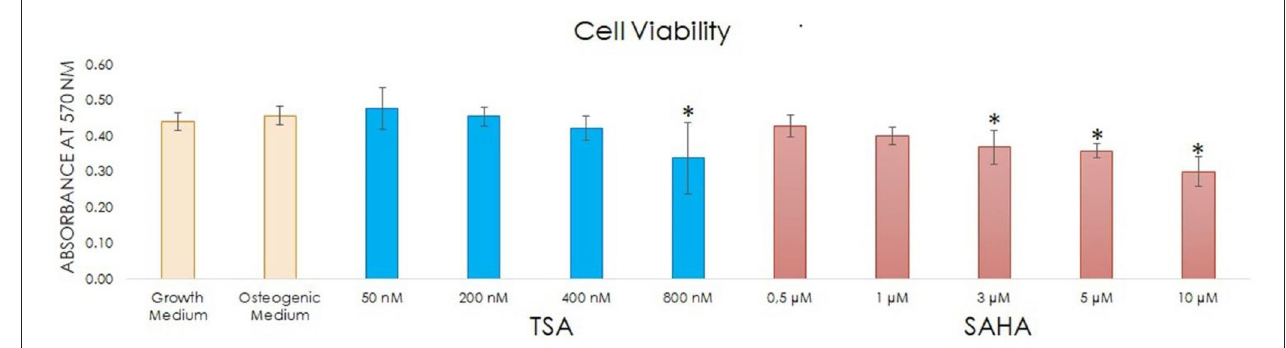
FIGURE 1 | Cell viability after culturing hDPCs with and without TSA and SAHA for 72h was assessed using an MTT assay (one-way ANOVA, Tukey’s HSD post hoc test, Asterisks indicate a significant difference compared with the induction control at p < 0.05, n = 4).